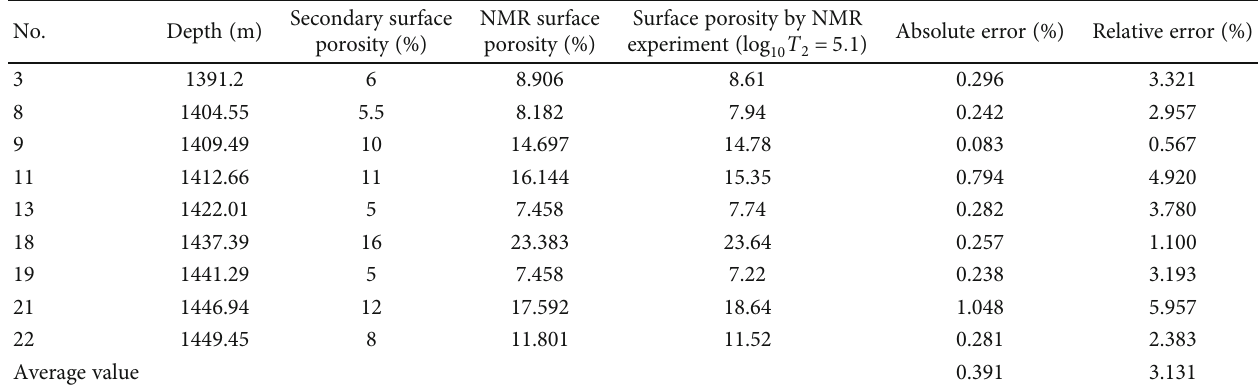
Figure 9: Linear relationship between secondary porosity and secondary porosity (16 cores) in NMR experiments at log Table 4: Statistical table of errors in the calculation of secondary porosity by NMR. No.